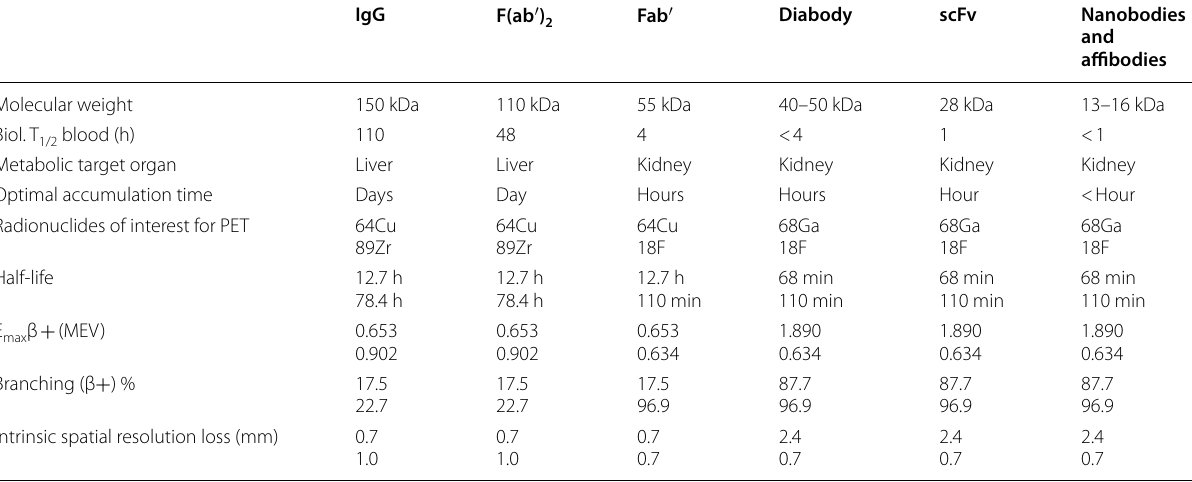
Table 1 Summary of salient properties of immune and peptide-associated tracers and radioisotopes matching their half-life